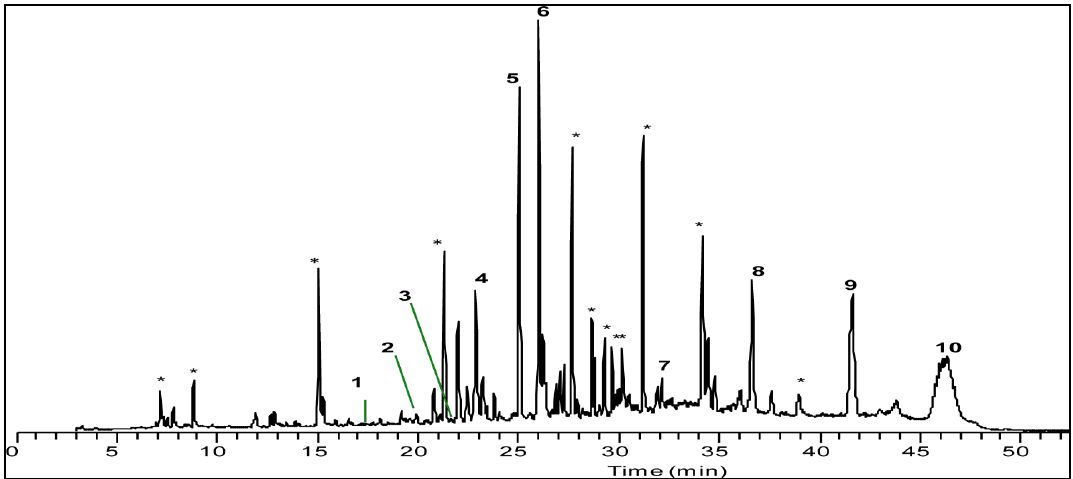
Fig. 2. Chromatographic separation and identification of Chl catabolites from the extracts of digestive products of A. urticae larvae. Total ion chromatogram (TIC) of LC-MS, APCI full scan (+) mode and peak assignment of Chl catabolites.